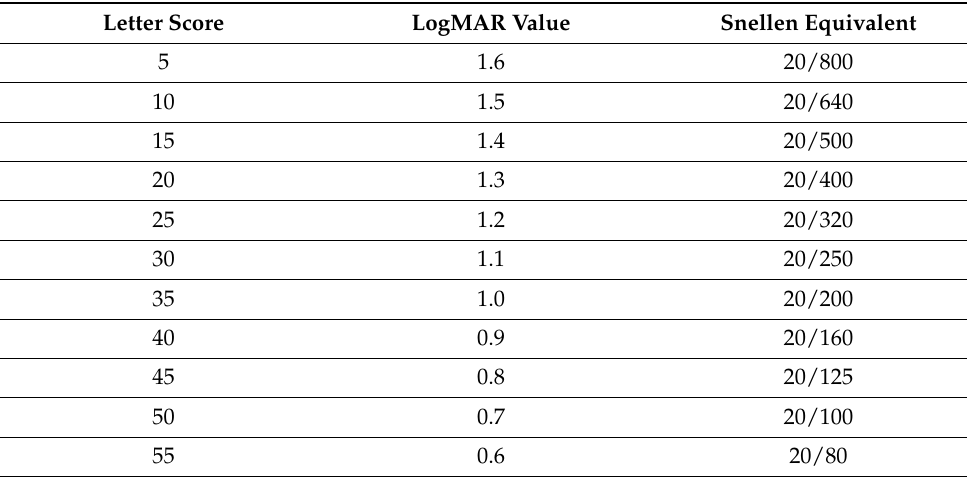
Table 3. Visual Acuity convertion